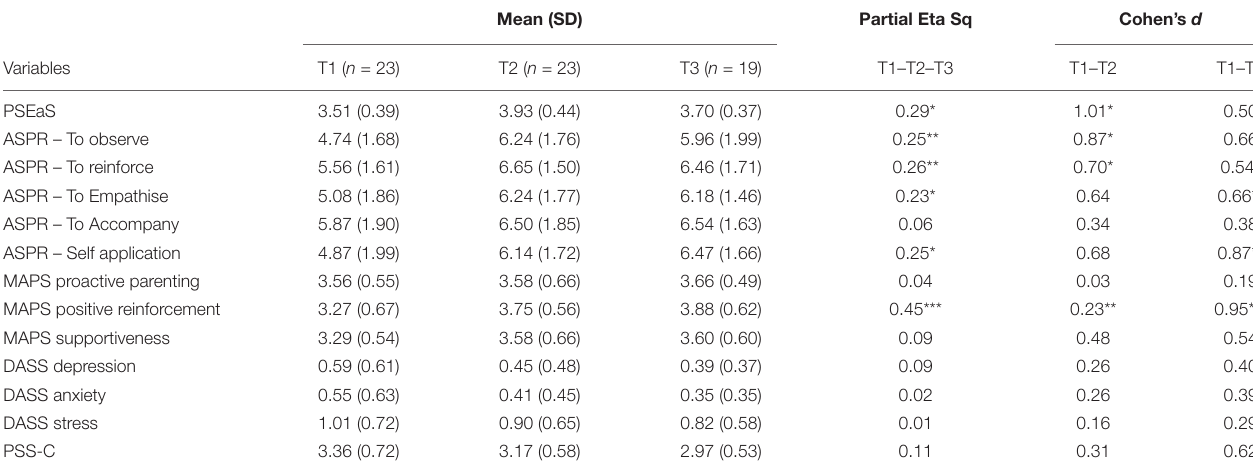
TABLE 4 | Means and changes in outcome variables across timepoints. Mean (SD) Partial Eta